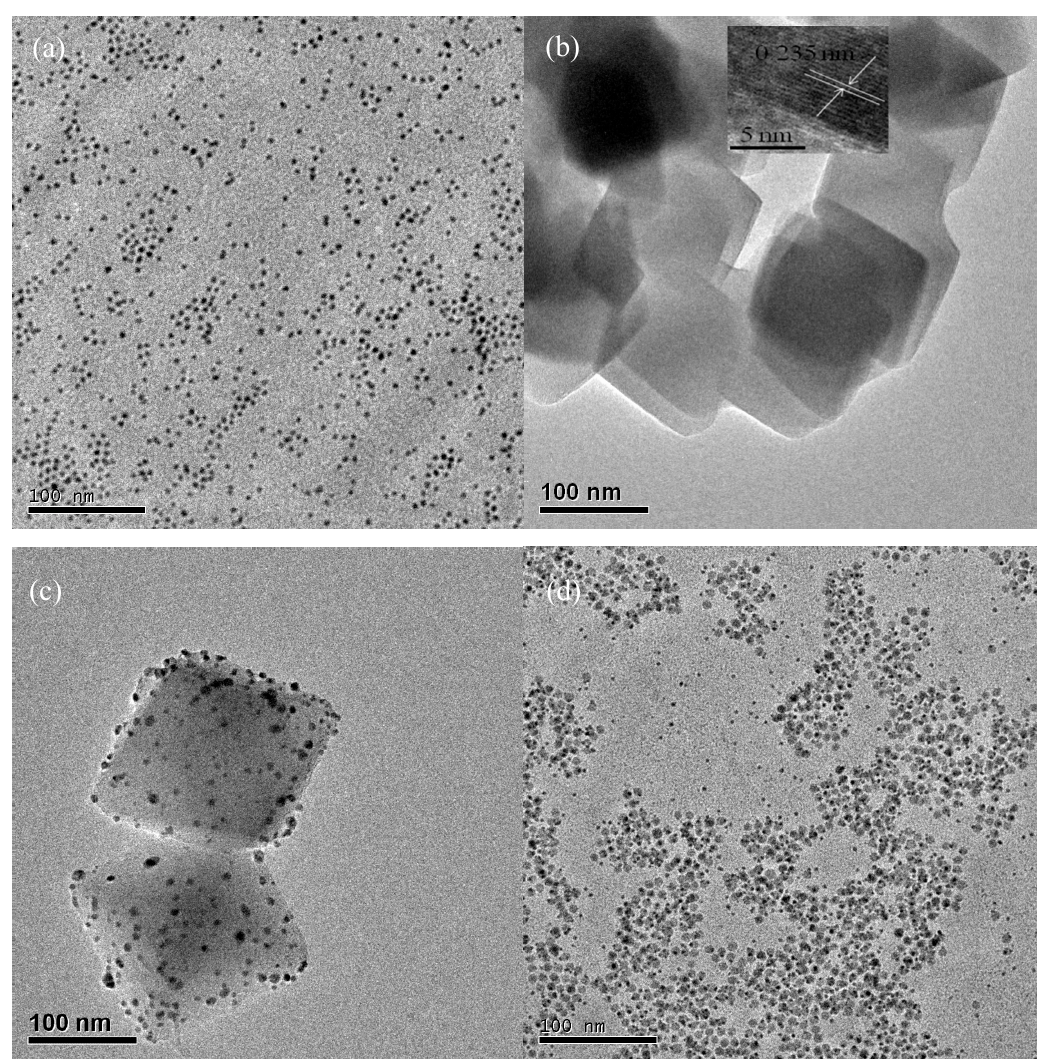
Figure 2. TEM images of Ag NPs ( a ), TiO 2 NSs ( b ), Ag/TiO 2 NSs ( c ), and Ag/TiO 2 NPs ( d ).